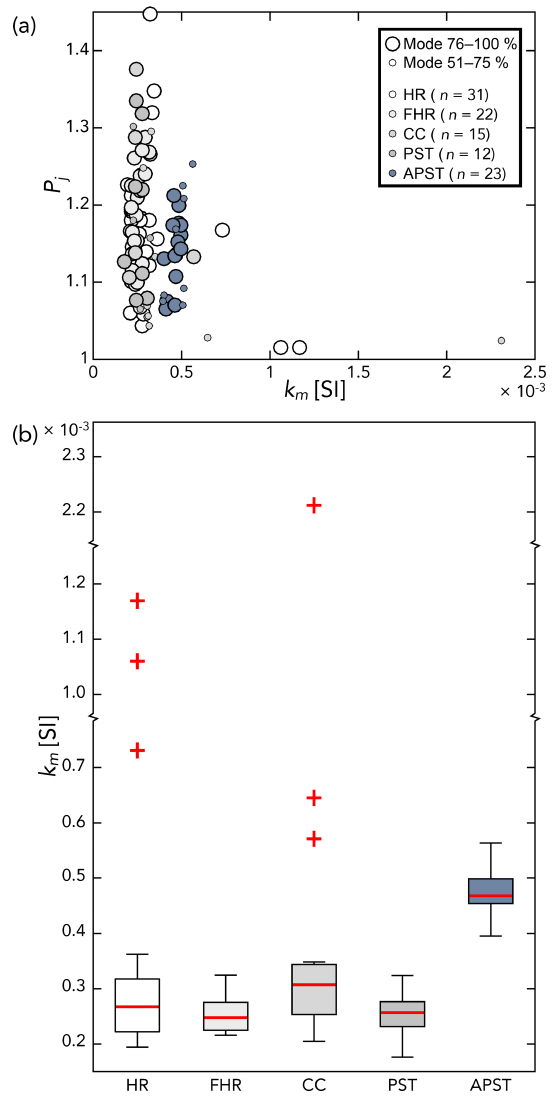
Figure 8. (a) Normalized mean susceptibility ( k M ) versus degree of anisotropy ( P j ). The mean susceptibility of altered pseudotachylyte specimens is about twice that of the other rock type specimens (b) . For abbreviations, see Fig.